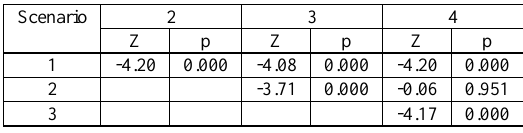
Table 7. Wilcoxon signed-rank test results (non-dominant hand)